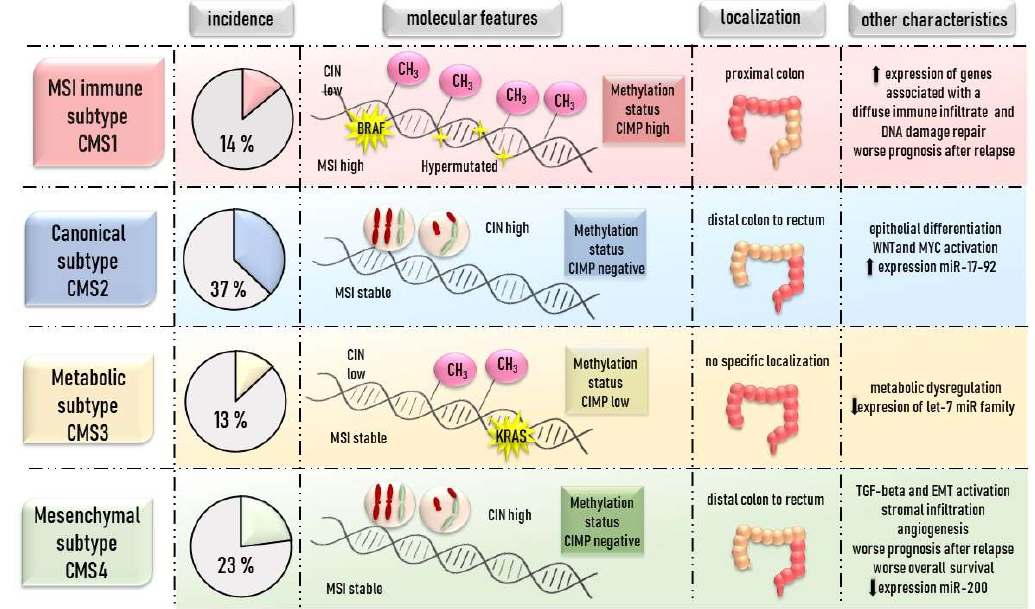
Figure 1. Consensus molecular subtypes (CMS) classification as proposed by Guinney et al. [131].